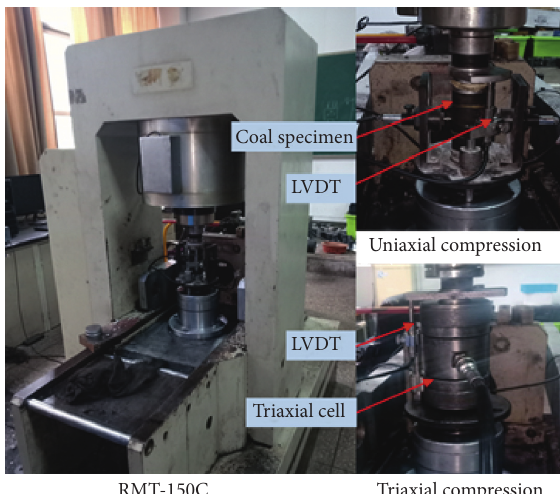
Figure 3: The RMT-150C experimental test